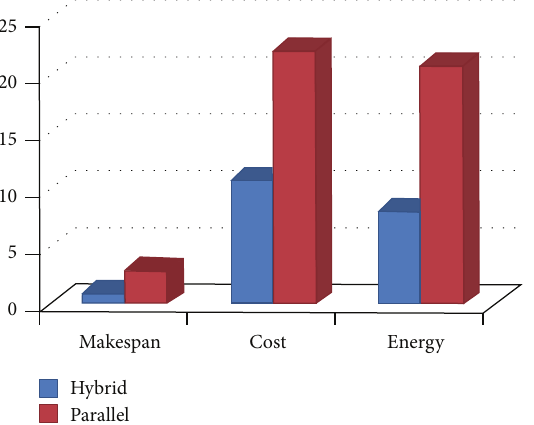
Figure 7: Improvement according to real world applications.